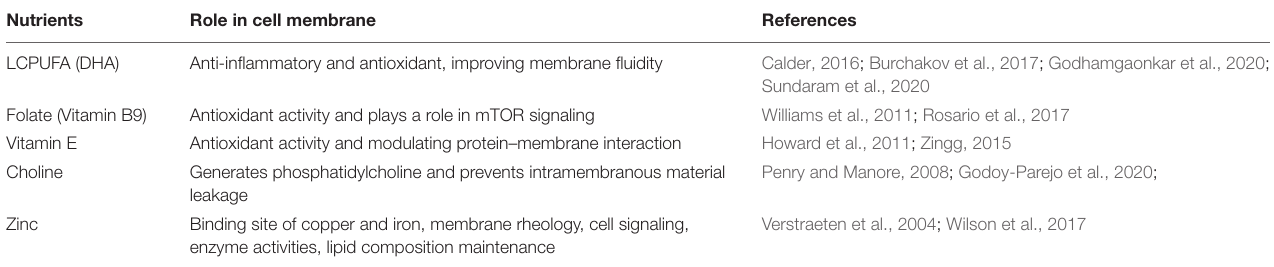
TABLE 1 | Role of nutrients in the cell membrane. Nutrients Role in cell